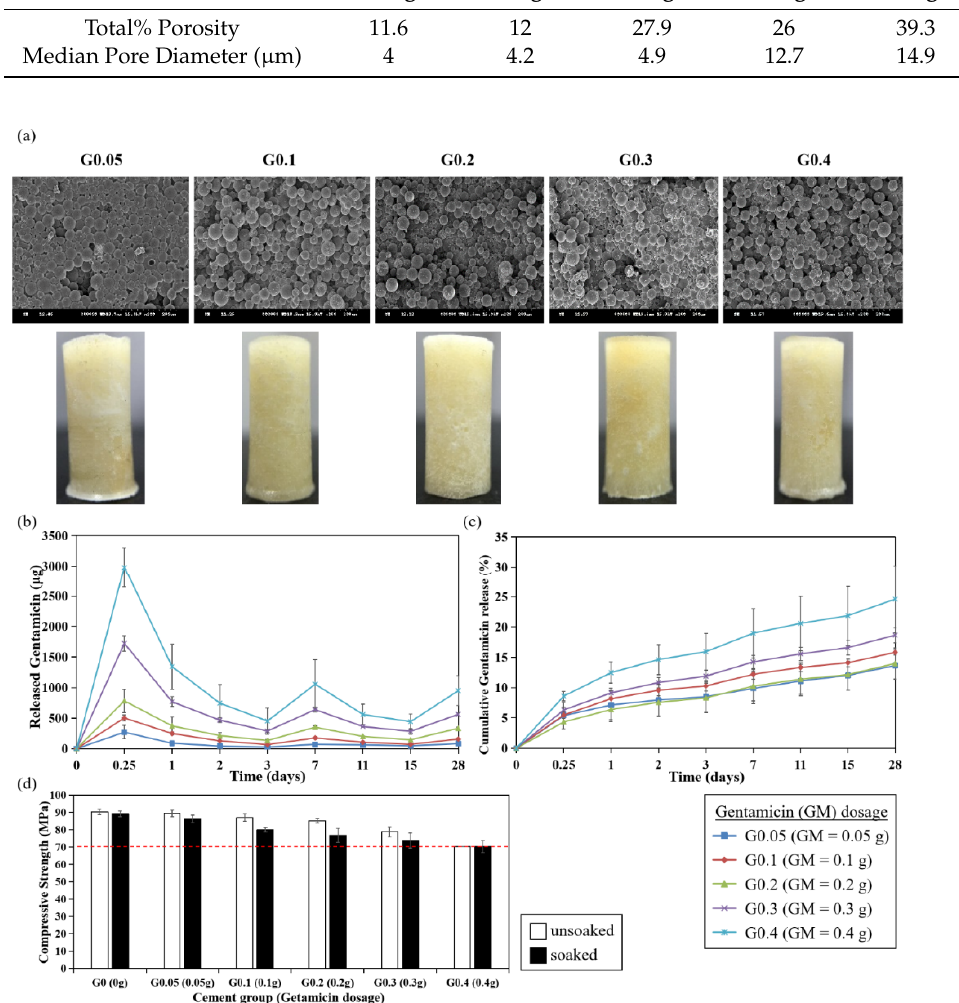
Figure 7. Effects of gentamicin doses on antibiotics elution and compressive strength of PMMA bone cement. ( a ) SEM images and morphology of PMMA cement. ( b ) Gentamicin elution profile. ( c ) Cumulative gentamicin release percentage. ( d ) Compressive strength. White bar: unsoaked cement; black bar: PBS-soaked cement. The dashed line indicates the ISO standard for compressive strength (70 MPa).